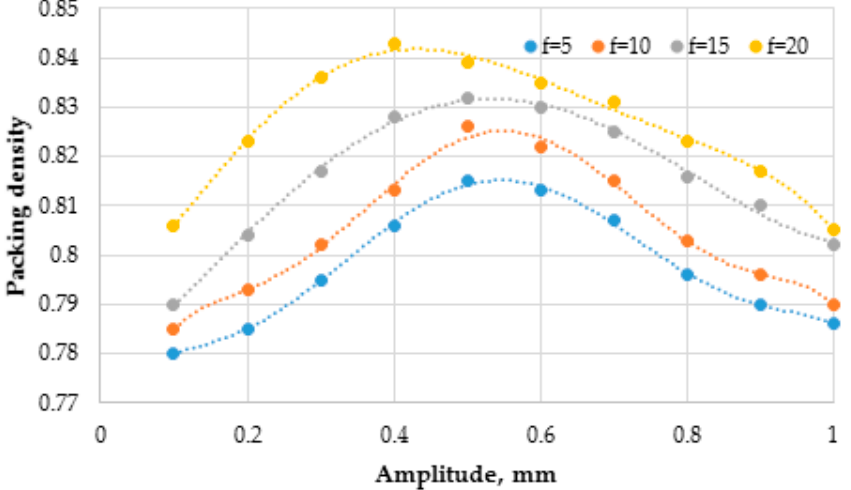
Figure7. E ff ectofamplitudeonpackingdensityofpowderswithGaussiandistribution(average particle Figure 7. Effect of amplitude on packing density of powders with Gaussian distribution (average diameter of 300 µ m and a standard deviation of 0.2) at di ff erent particle diameter of 300 μ m and a standard deviation of 0.2) at different frequencies.